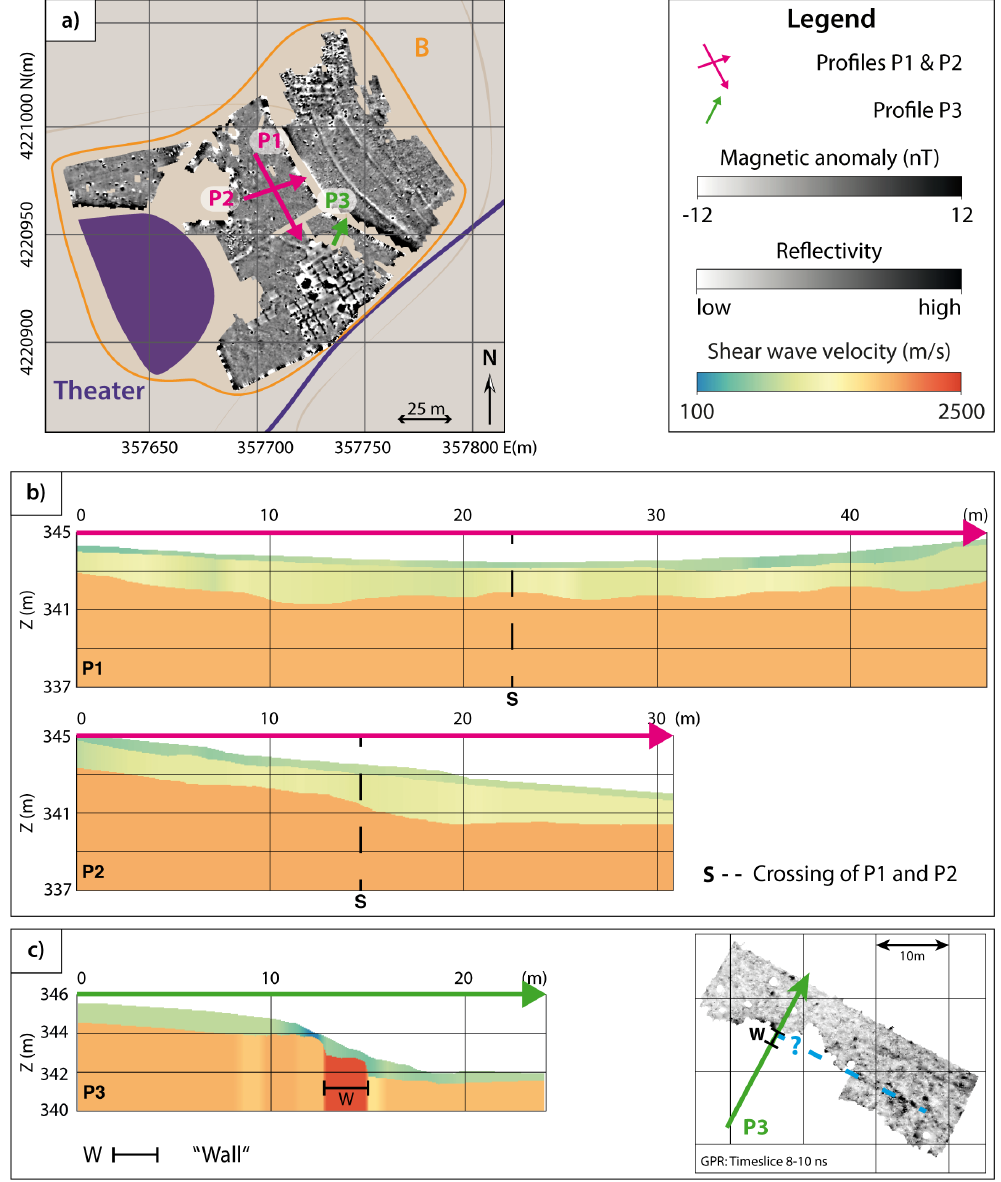
Figure 7. Case 3: Theater area northeast of Aigeira’s acropolis. ( a ) Sketch of the second survey area in Aigeira (cf. area B in Figure 1b) with the magnetic map. The locations of the seismic profiles is shown here. ( b ) Depth section in regard of shear wave velocity of the crossing lines for bedrock investigation. ( c ) Seismic depth section (left) and GPR timeslice (8–10 ns; right) with a wall